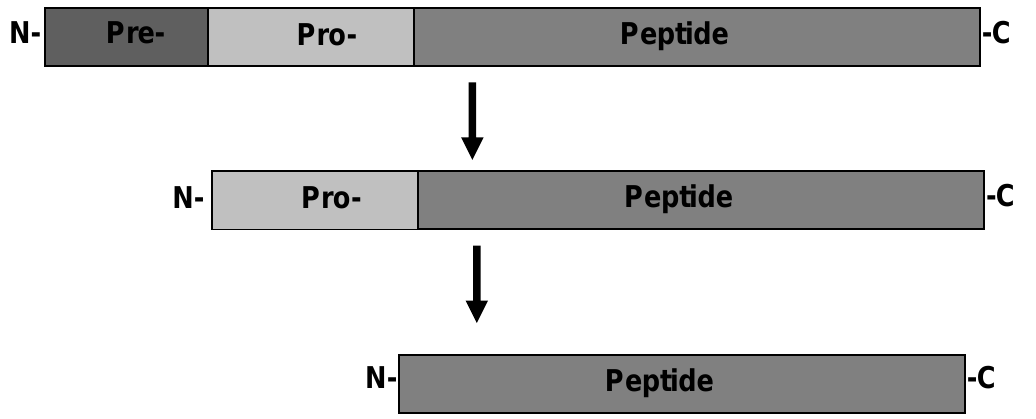
FIGURE 2. A pre- or signal sequence N-terminal to the prosequence provides targeting to an intracellular membrane structure and must be post-translationally cleaved to form the inactive propeptide that can be stored. Whereas in eukaryotes the target is the endoplasmic reticulum, in bacteria, it is the cytoplasmic